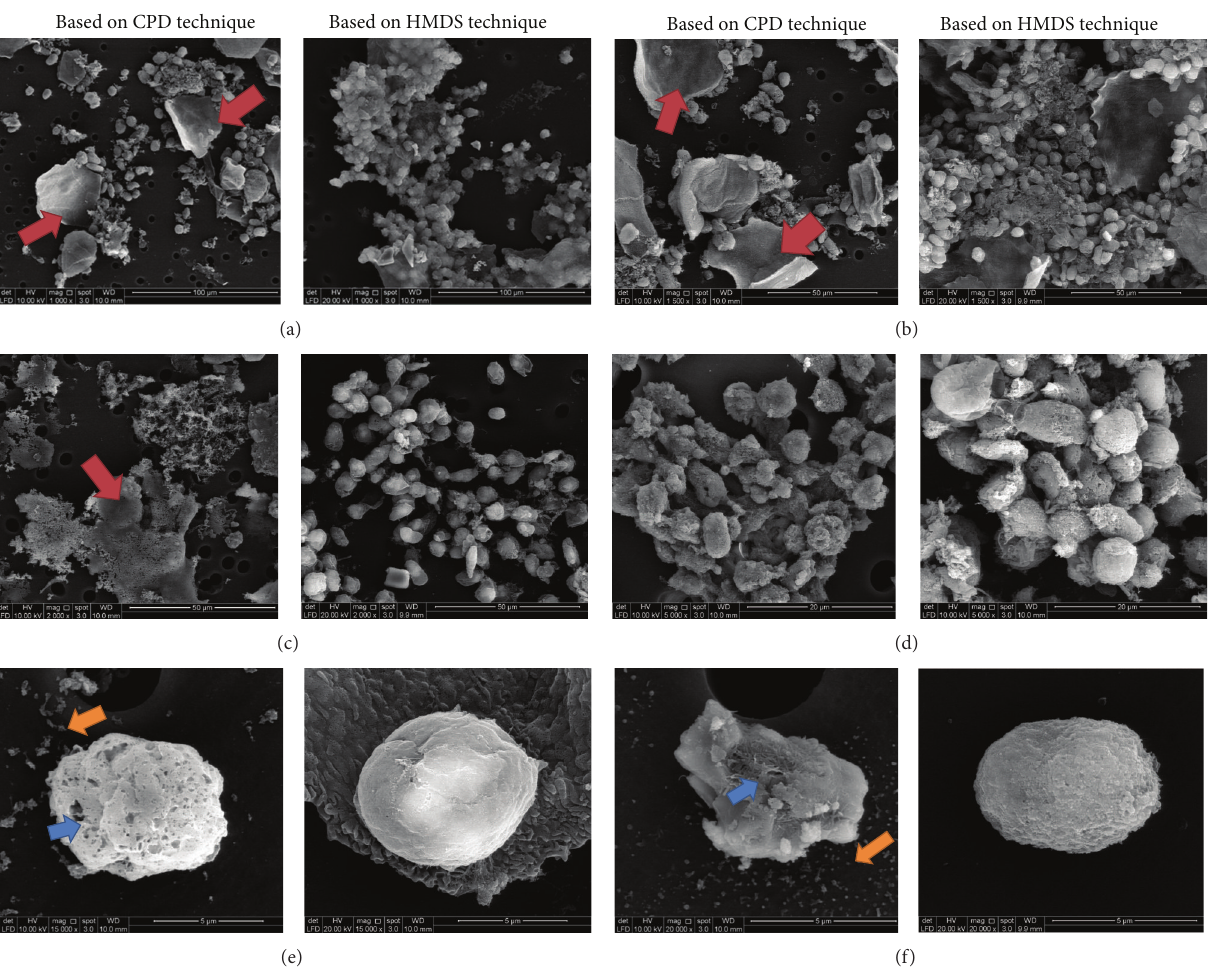
Figure 5: Comparison FE-SEM images of sample preparation based on CPD and HMDS techniques in different magnification; the red arrows refer to drying plate artifacts, the orange arrows refer to pellet artifacts, and the blue arrows refer to membrane blebs. (a) 1000x magnification. (b) 1500x magnification. (c) 2000x magnification. (d) 5000x magnification. (e) 15000x magnification. (f) 20000x